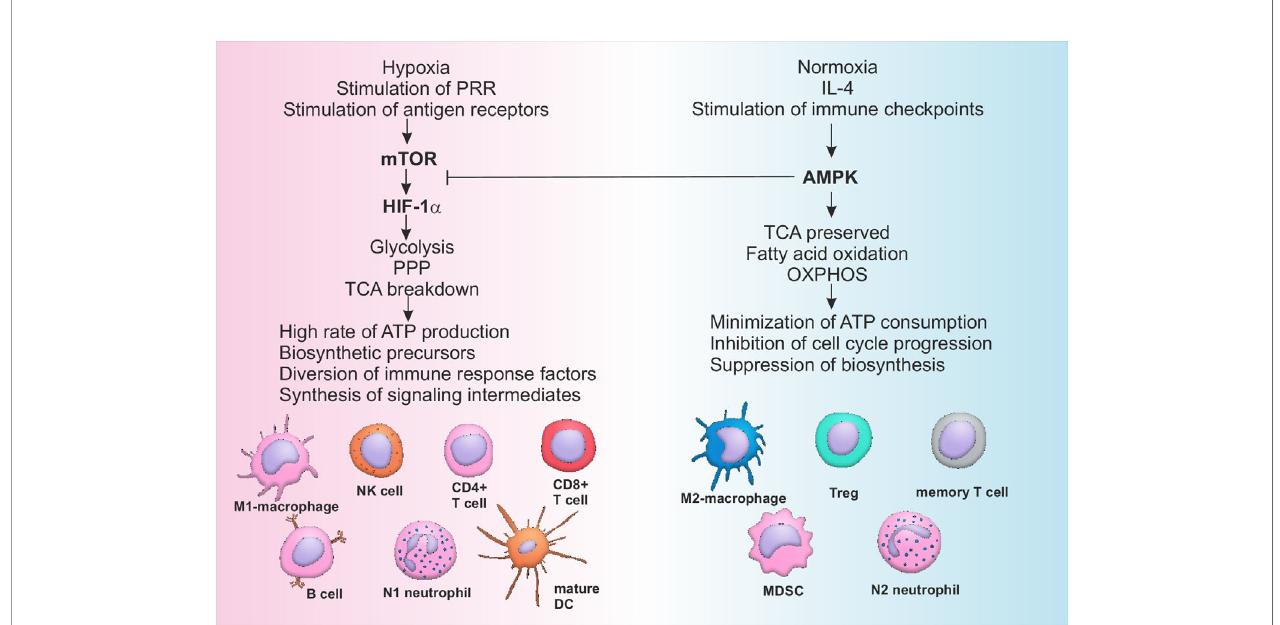
FIGURE 2 | Pathways of metabolic reprogramming in immune cells. Activation of mTOR during hypoxia and stimulation of PRR by DAMPs or antigen receptors on T- and B-lymphocytes by antigens leads to the sustained stimulation of HIF-1 a , which in turn activates glycolysis and pentose-phosphate pathway, breaking down tricarboxylic acid (TCA) cycle. All of the above mentioned metabolic pathways are associated with high rate of ATP production, generation of biosynthetic precursors (nucleotides, fatty acids, ribose, amino acids), diversion of immune suppressive factors such as phosphoenolpyruvate into glycolytic pathway and production of cofactors (such as NADH). As a consequence cells of the immune system are activated and acquire in fl ammatory phenotype. Restoration of the normal oxygen supply or anti-in fl ammatory signaling, sometimes combined with checkpoint (PD-1) activation, stimulates AMPK, characterized by the suppressive activity towards mTOR. AMPK supports integrity of TCA, stimulates OXPHOS and fatty acid oxidation, minimizing ATP consumption and inhibiting cell cycle and biosynthesis. Switching from catabolism to anabolism represents a stimulus for the development of anti-in fl ammatory and memory cells. AMPK, AMP activated protein kinase; ATP, Adenosine triphosphate; CD, Cluster of differentiation; DC, Dendritic cell; HIF, Hypoxia induced factor; IL, Interleukin; MDSC, Myeloid derived suppressor cell; mTOR, Mammalian target of rapamycin; OXPHOS, Oxidative phosphorylation; PPP, Pentose phosphate pathway; PRR, Pattern recognition receptors; TCA, Tricarboxylic acid cycle; Treg, T regulatory